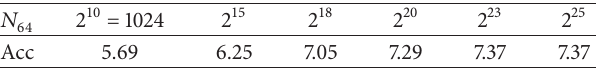
Table 5: The results of experiments (data are transmitted through four 64-bit high-performance ports and 𝜂 = 64 ).